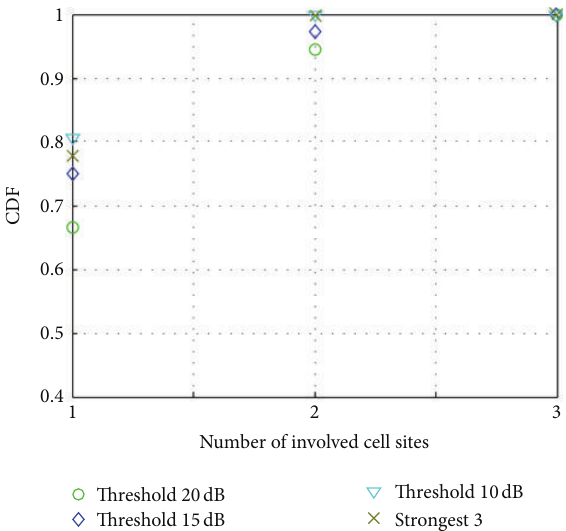
Figure 5: The partial CoMP concepts have a significant gain compared to intrasite cooperation scenarios, especially in the low- SINR regions.